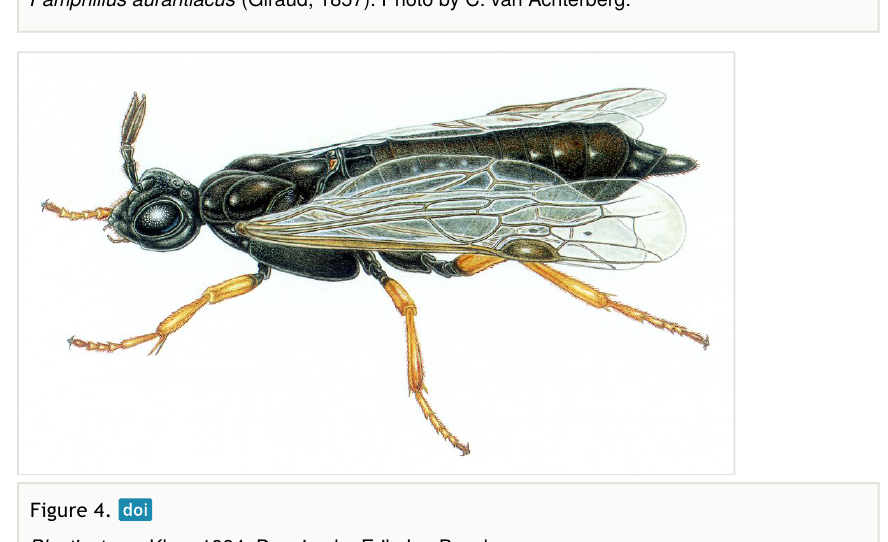
Blasticotoma Klug, 1834. Drawing by Erik-Jan